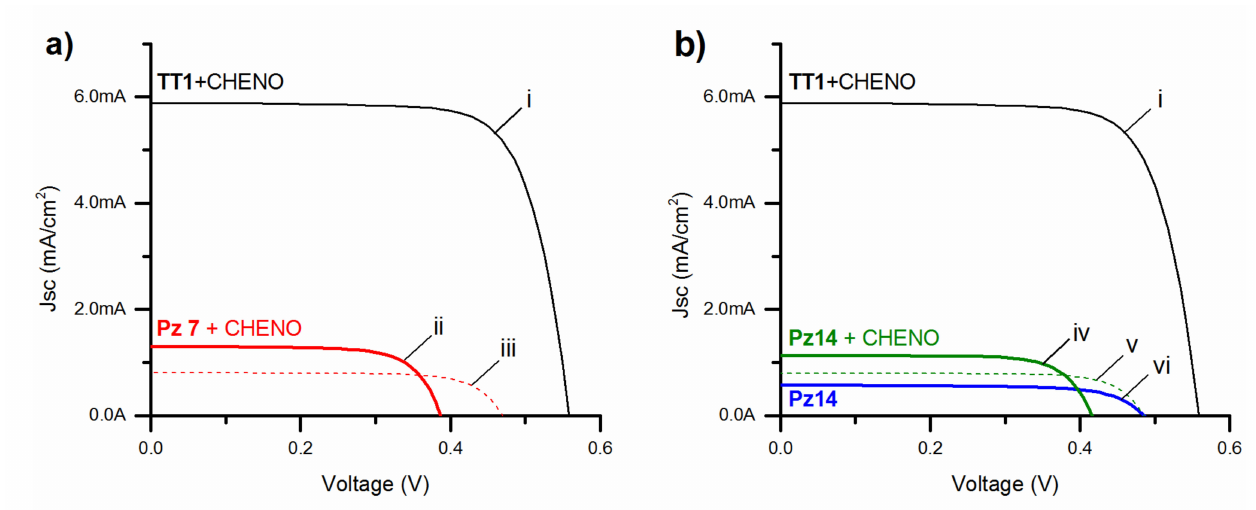
Figure 6. I/V curves of ( a ) Pz 7 and ( b ) Pz 14 using two different electrolytes (A or B), together with the reference cell TT1 : (i) TT1 +CHENO/A; (ii) Pz 7 +CHENO/B; (iii) Pz 7 +CHENO/A; (iv) Pz 14 +CHENO/B; (v) Pz 14 +CHENO/A; (vi) Pz 14